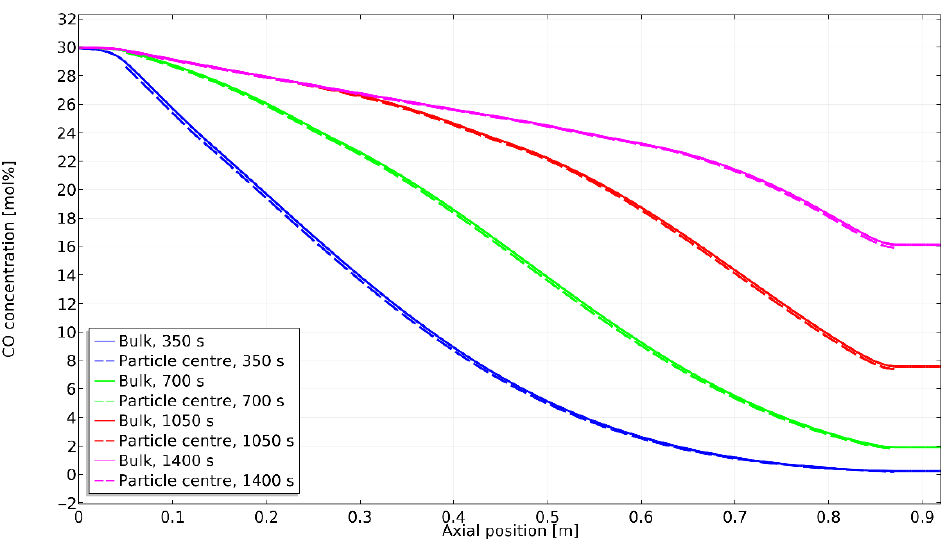
11 of 19 Figure 8. Experimental (blue circles) and model predicted (red line) CO breakthrough curves. The feed concentration of CO was 30 mol% (see Table 1, case 2), while the concentra- tion at the outlet was 23 mol%. The supplementary consumption of CO was measured experimentally and was attributed to carbon deposition during the reduction reaction.